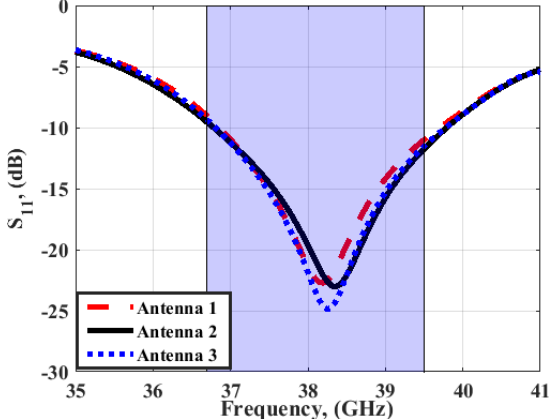
Figure 17. The proposed MIMO antenna attached with FSS structures ( a ) Three antennas with different FSS cell sizes ( b ) side view ( c ) 3D view.